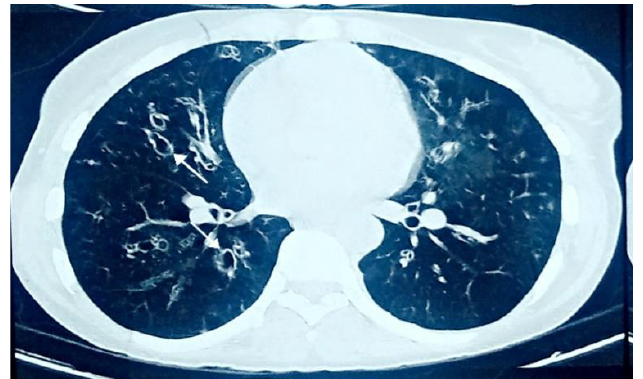
Figure 2. HRCT of the thorax showing moderate to gross tubule-cystic bronchiectasis with surrounding fibrosis in both lung fields. Signet ring sign positive.